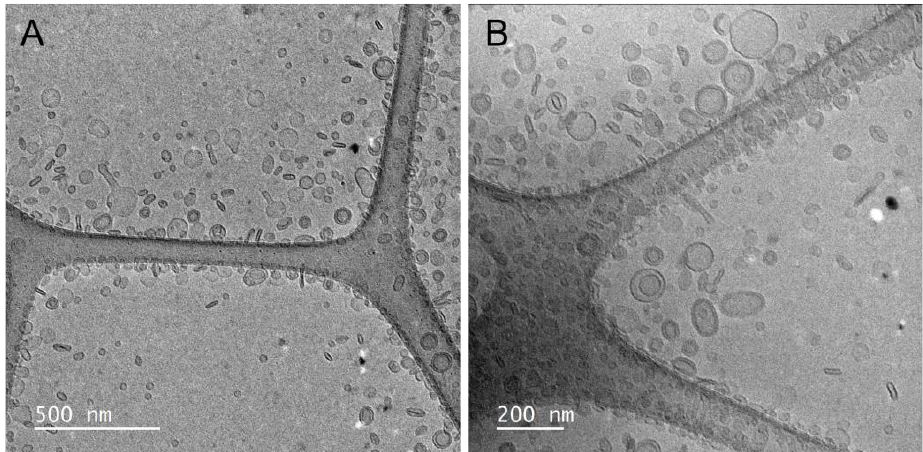
Figure 2. Cryo-TEM images of P. spinosa PG-PEVs. Two magnifications are shown: 15,000 × ( A ) and 20,000 × ( B ).